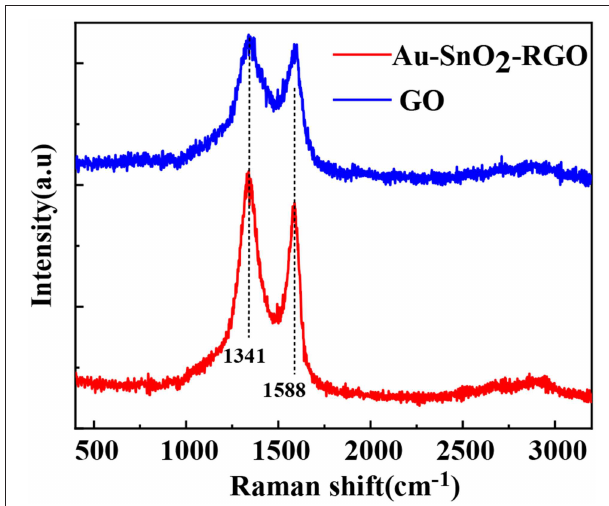
FIGURE 5 | Raman Shift of AuNPs-SnO 2 -rGO and GO.